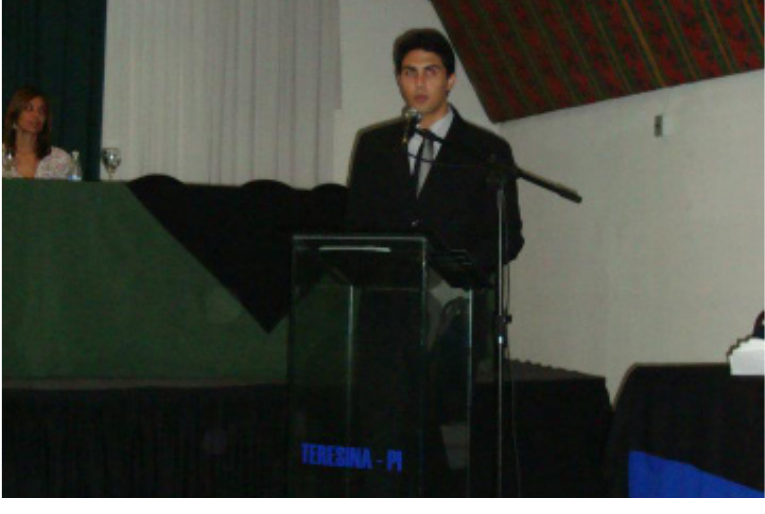
Figure 1. Edson S. Ferreira-Filho, President of the 18 th Academic Medical Congress of Piaui 2011 at Opening.